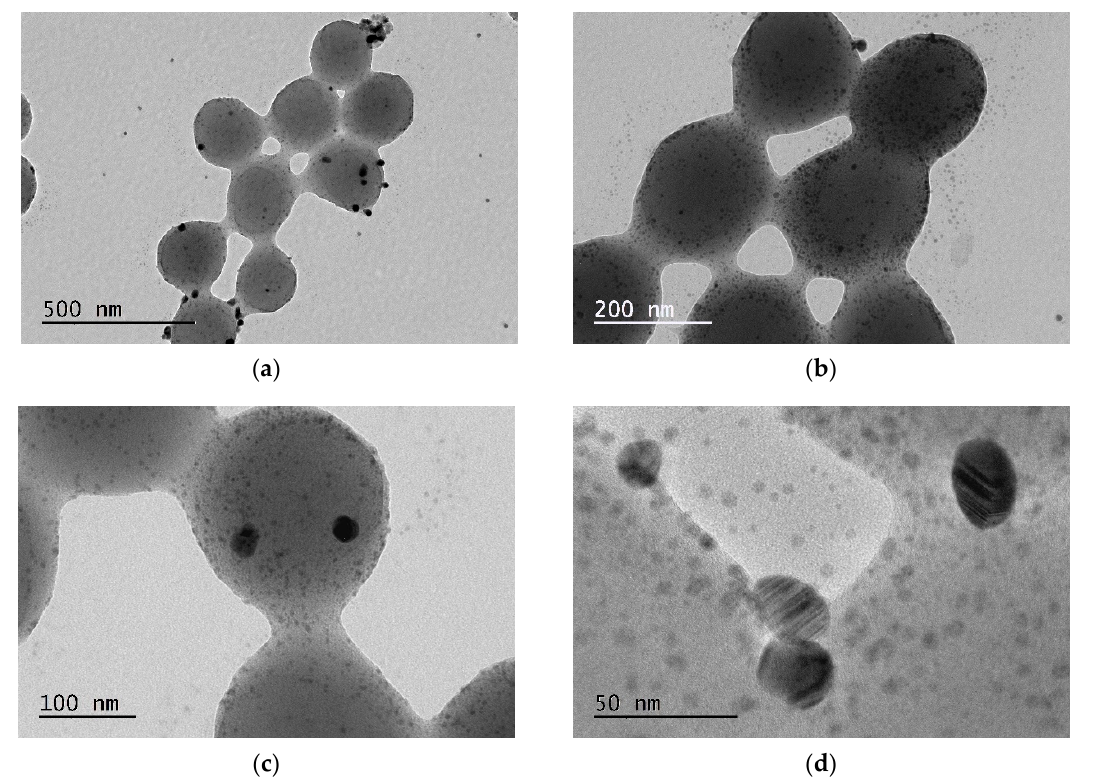
Figure 6. ( a – d ) TEM images of the PMAA@Ag sample (3 h stirring in AgNO 3 ) under different magnifications.